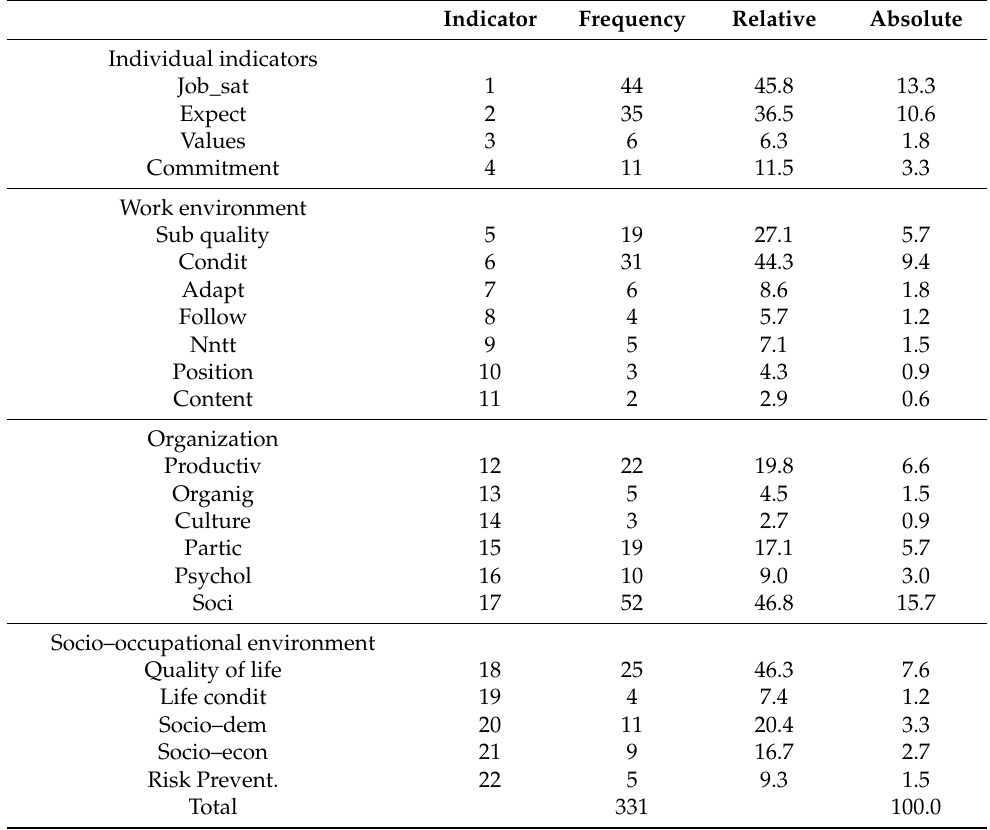
Table 14. Descriptive statistics of stress intensity